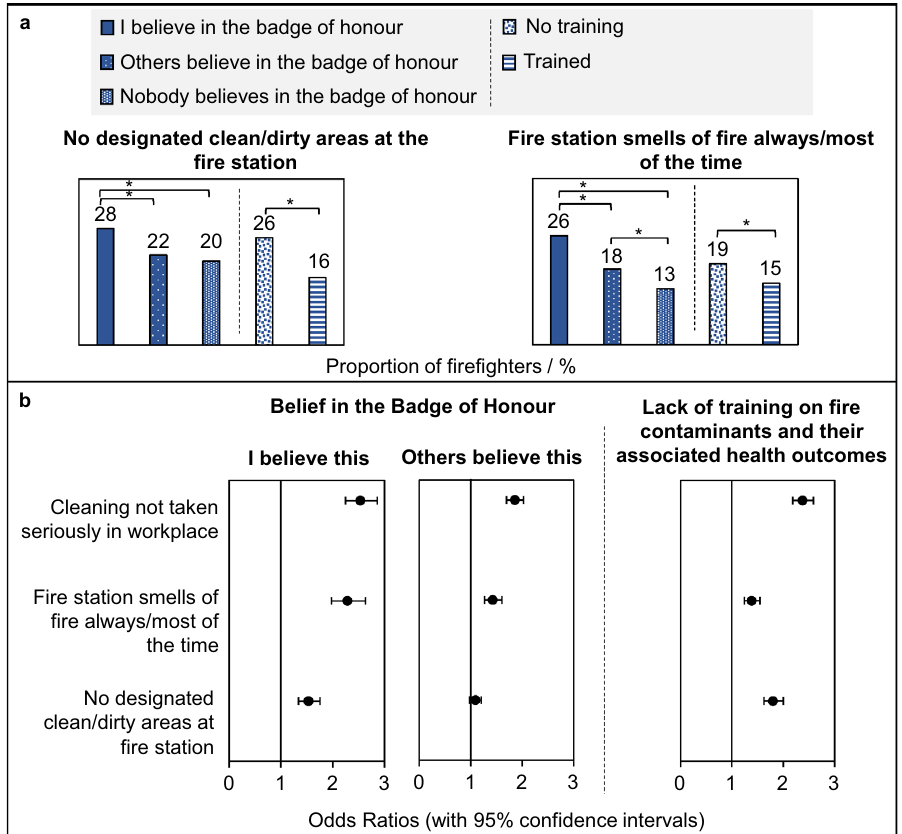
Figure 6. Belief in the BoH/lack of training and workplace contamination . ( A ) The proportion of firefighters, and ( B ) the crude odds ratios, for firefighters in each BoH belief/training status category whose workplaces have no designated clean/dirty areas or smell of fire always/most of the time. *Indicates a p-value of < 0.05 for the z-score test for difference in